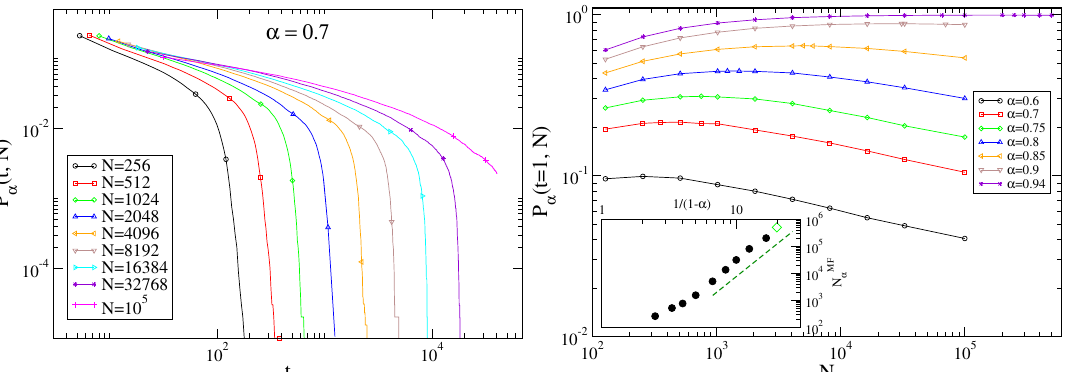
Figure 2: Left panel: P α ( t , N ) is plotted against t for α = 0.7 and various system sizes N on a double logarithmic scale. Each curve is averaged over 10 5 realisations. Right panel: P α ( t = 1, N ) is plotted with log-log scale against N for various values of α . In the inset the value N MF corresponding to the maximum of any curve is plotted α against 1 / ( 1 − α ) with log-log scale. The last point (green diamond) is a lower bound since the maximum of the corresponding curve in the main figure is not yet reached at the longest simulated time. The dashed green line is the behavior ( 1 − α ) − 4